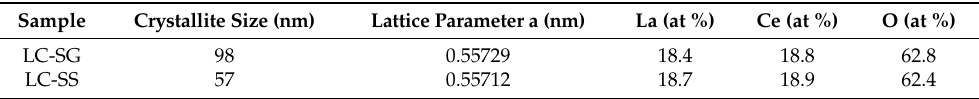
Table 1. Crystallite sizes, lattice parameters and chemical composition of the LC powders calcined at 1400 ◦ C.